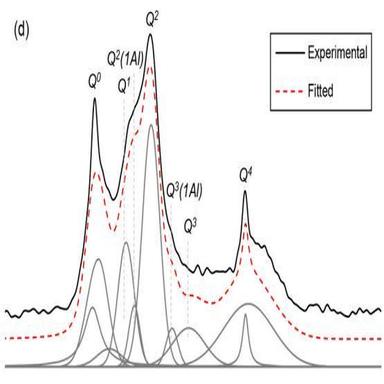
Relative Si fraction (%) of the samples as calculated from the deconvolution of 29Si NMR spectra.